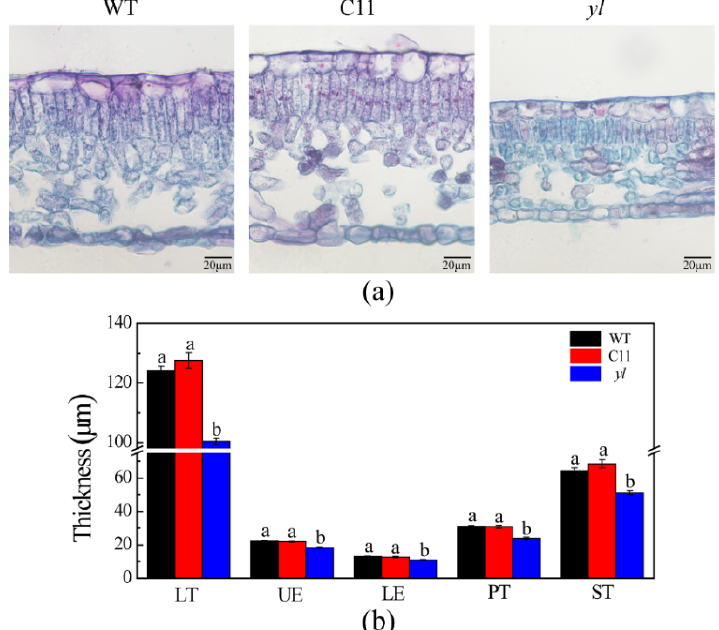
Figure 2. Leaf anatomical characteristics of WT, C11, and yl . ( a ) Leaf transections of WT, C11, and yl lines. ( b ) Leaf anatomical structure of WT, C11, and yl . Lamina thickness, LT. Adaxial epidermis thickness, UE. Abaxial epidermis thickness, LE. Palisade parenchyma thickness, PT. Spongy parenchyma thickness, ST. Error bars represent the standard deviation (SD) of 20 measurements from five individual plants.